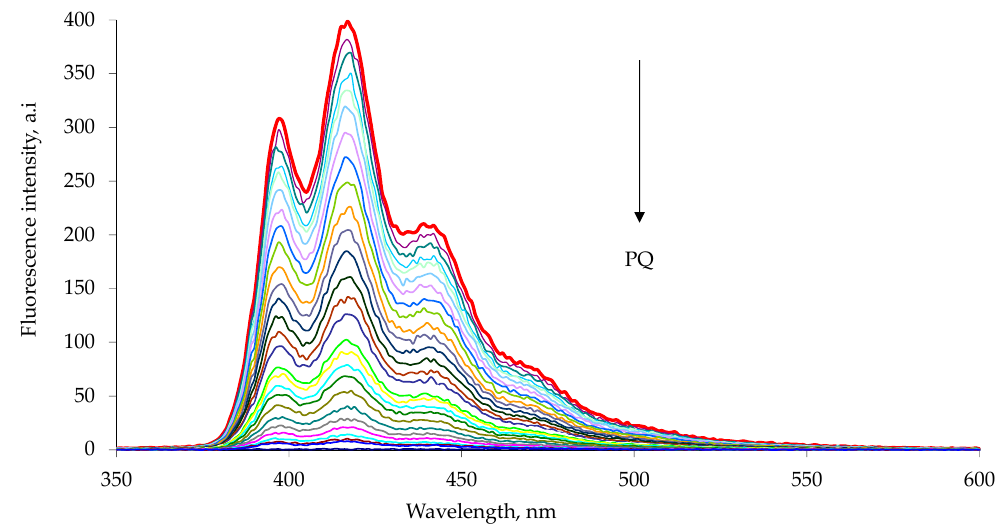
Figure 4. Fluorescence quenching of 1b host with increasing paraquat concentration, PQ, in chloroform–methanol 1:1 solution at 25 °C. The experimental data are reported in Table 2. The emission spectra were measured with excitation at 263 nm. Each spectrum is reported with different color line (Entry 1–25 Table 2). Table 3. Experimental data for the determination of spectra reported in Figure 5. The V 1a and V DQ volumes refer to an initial 1a solution with a concentration of 45.5 μ g L − 1 and diquat, DQ, solution with a concentration of 1650 μ g L − 1 , respectively. The final volume of each solution was made up to a total volume of 3000 μ L by fixing with the solvent mixture.